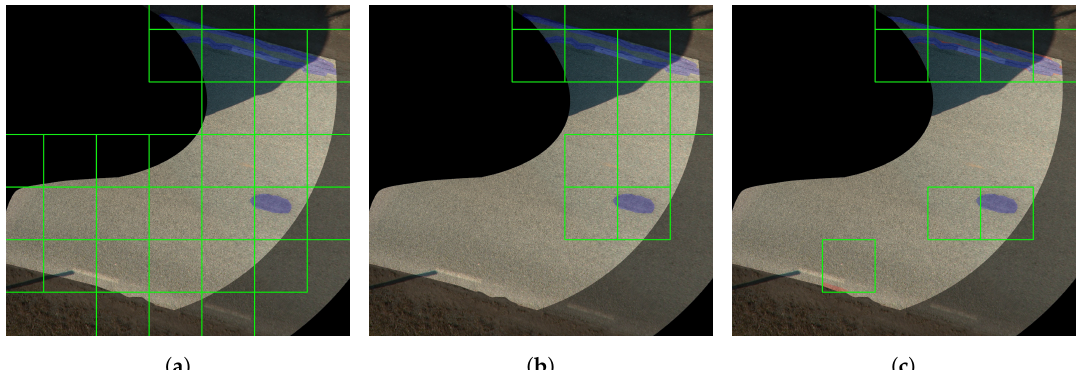
Figure 14. Three of the sampling strategies visualized on an orthoframe. Each green square is of size 336 × 336 and added to the given dataset. For illustrative purposes, annotated defects are marked in blue and predicted false positives (only shown in c) are marked in red. For the sake of visual clarity, partial overlapping is not displayed and the focused part of the road in conjunction with the road area mask is highlighted. ( a ) Full sampling.; ( b ) Dilated defect contour sampling.; ( c ) Defect contour sampling with false positives. Table 1. The datasets used in this work, generated from the orthoframes reserved for training and